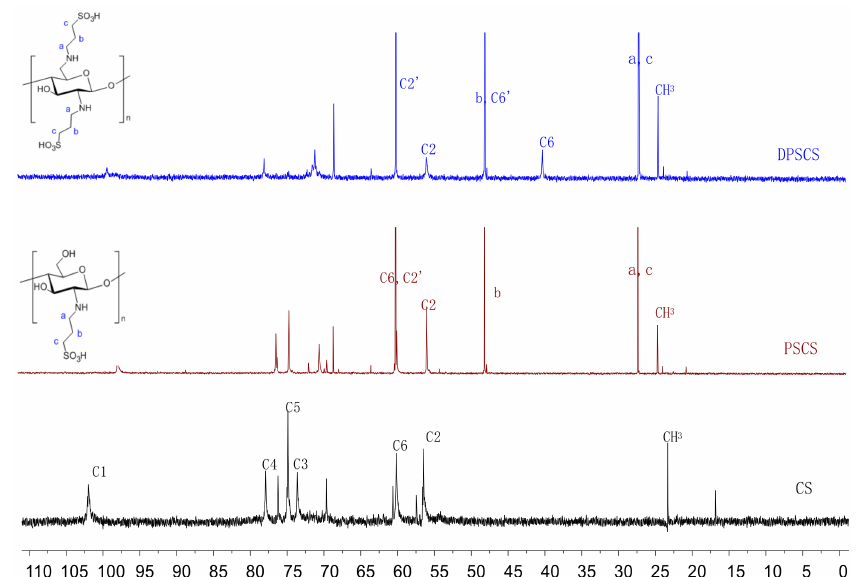
Figure 3. 13 C NMR spectra of chitosan